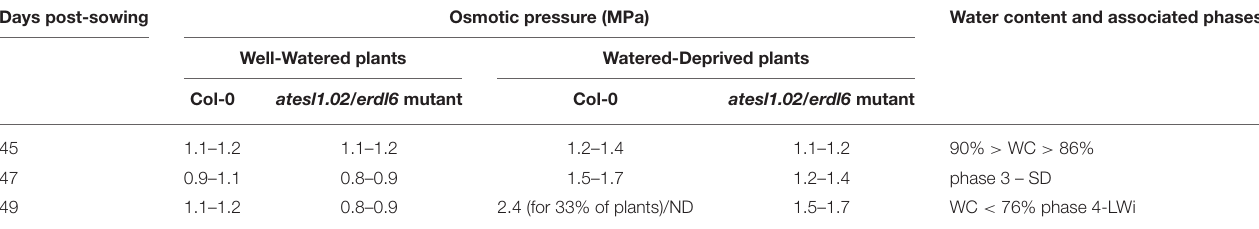
TABLE 1 | Osmotic pressure (MPa) in the leaves of Arabidopsis thaliana Col-0 and atesl1.02/erdl6 mutant grown under well-watered (WW) and WD culture conditions at 45, 47, and 49 days post-sowing. Days post-sowing